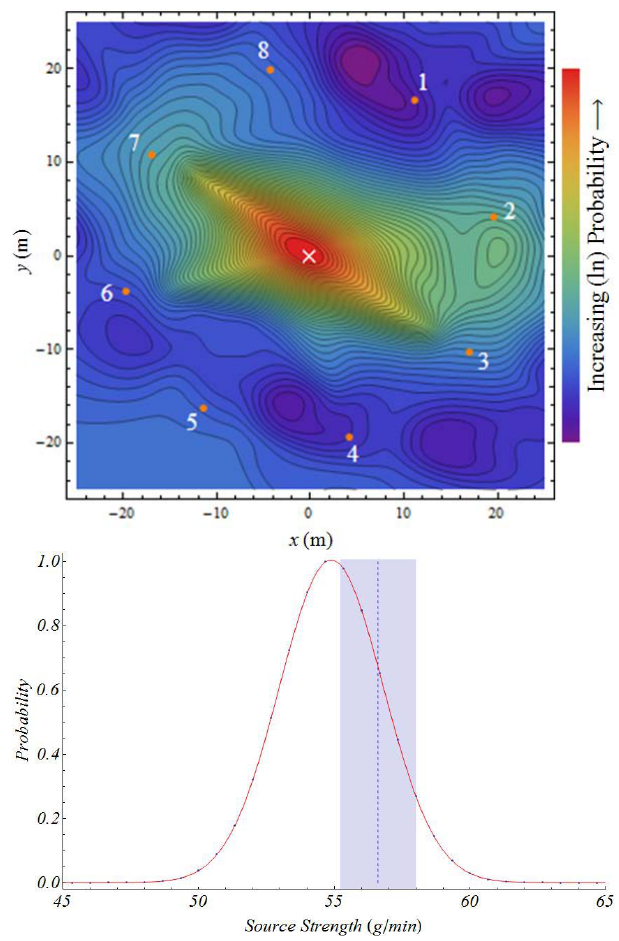
Fig. 10. Result of the FTIR-tomography detection of a CO 2 point source release in a 50 × 50m area. In the upper frame, x marks the actual point location (0, 0 m) from where CO 2 and N 2 O were re- leased, and 1–8 mark the locations of the sampling points for the FTIR analyser. The contours plot the a posteriori probability for the source point location determined from the atmospheric measure- ments ( − 0.5, 0.5m). The lower plot shows the known release rate (56.7 ±0.8gmin − 1 ) and the a posterior probability determined from the measurements (54.9 ± 4 (1 σ) g min − 1 ) . Figure from Humphries et al. (2012), Fig.